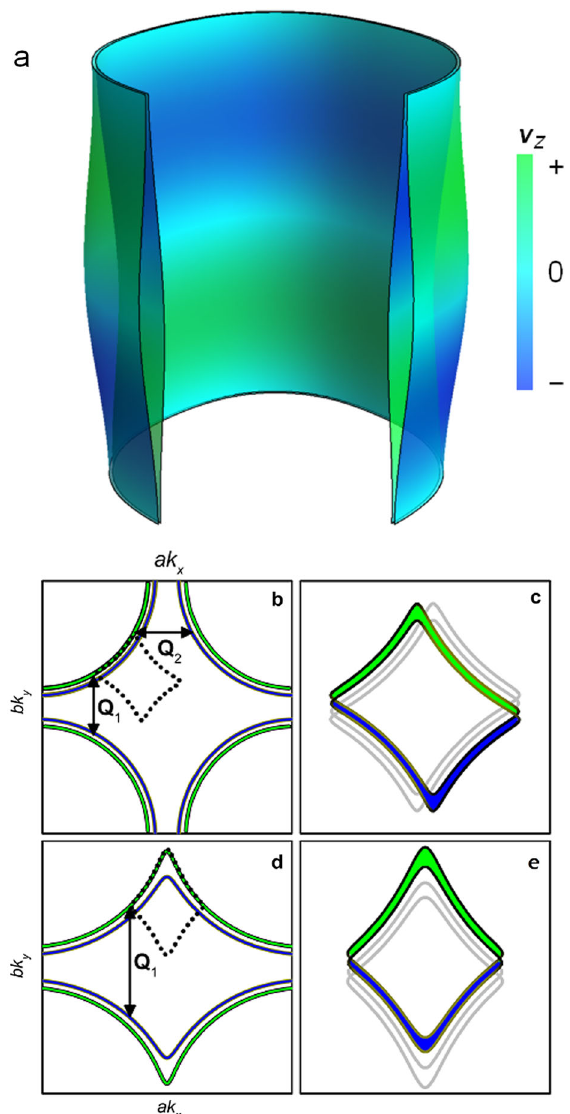
Fig. 3 Two possible anisotropic CDW reconstruction schematics forYBa 2 Cu 3 O 6.58 . The unreconstructed cuprate Fermi surface is a large hole-like cylinder. 18,32,65 a The bilayer copper oxide planes of YBa 2 Cu 3 O 6+ δ give rise to bonding and anti-bonding bands, whose interlayer velocities have opposite signs (one quarter of the Fermi surface has been cut away for clarity). b – e are projections of this surface into the k a – k b plane, from k z = − π /c to k z = 0, before ( b and d ) and after ( c and e ) Fermi surface reconstruction. The color scale signi fi es the sign of v z . The upper two panels involve two anisotropic CDWs, with Q 1 = ( δ ,0,1/2) and Q 2 = ( δ ,0,0) (refs 9, 11, 58), whereas the bottom two panels are the result of a large nematic distortion. 59 followed by uni-axial CDW reconstruction with Q = ( δ ,0,0), and where δ ≈ 0.3 according to X-ray scattering measurements. 9 Multiple Fermi surface sections, between which magnetic breakdown is possible, 17,24,39,40 are present after reconstruction: for clarity we color only one